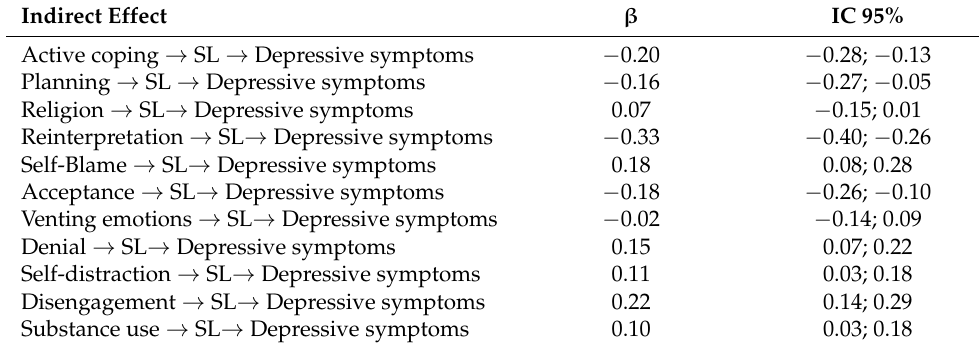
Table 5. Indirect